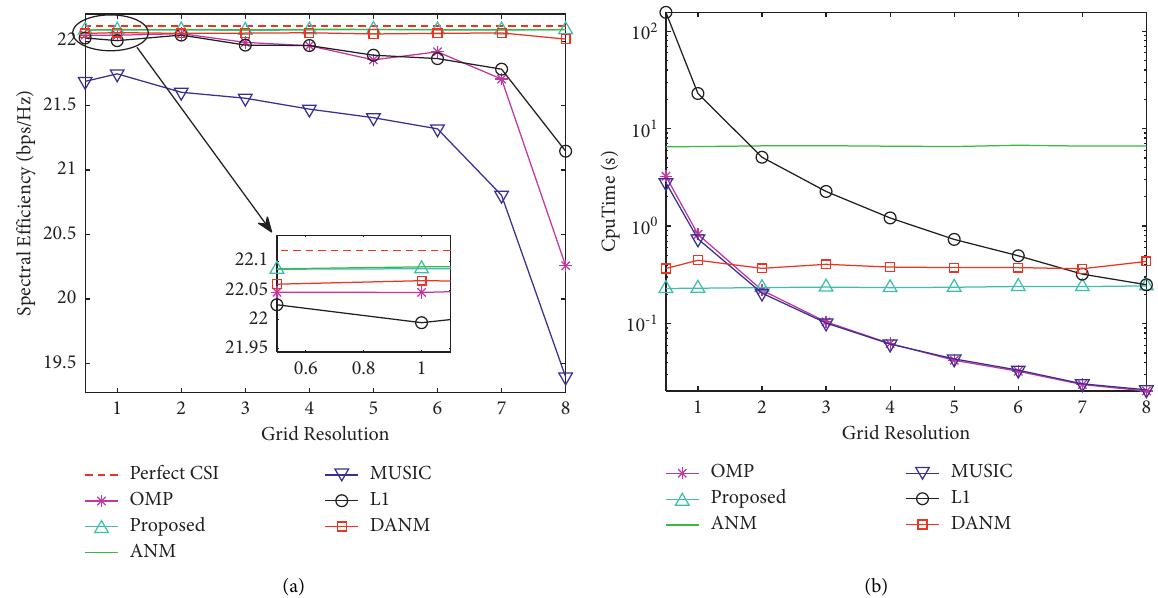
Figure 5: Spectral efficiency comparison with respect to the grid resolution. SNR � 5 dB. (a) Spectral efficiency comparison. (b) CPU time